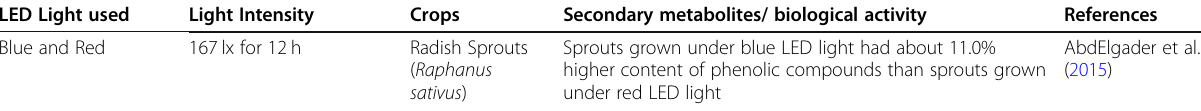
Table 3 LED employed for enhancement of secondary metabolites and biological activity in fruits and vegetables (Continued) LED Light